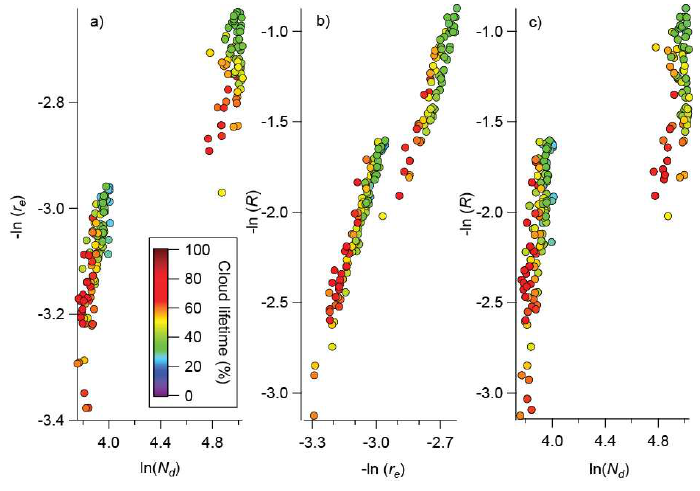
(cid:12) (cid:12) N d in denomi- (cid:12) LWP (=ACI with ∂ ln N d for a representative LWP bin 647 o